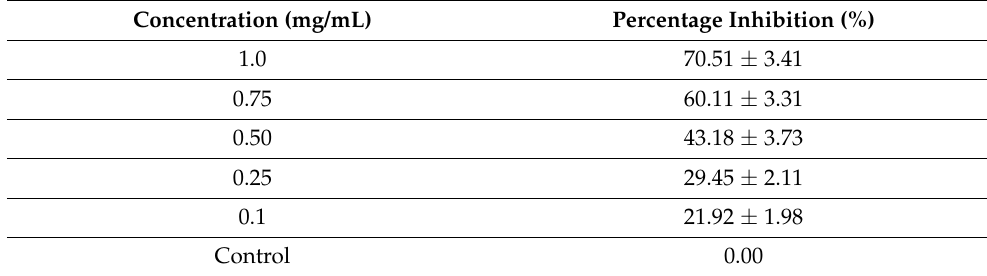
Figure 7. Antifungal activity analysis of ZnO NPs, in vitro. A. niger was grown at different concentrations of ZnO NPs including 1 mg/mL ( A ), 0.75 mg/mL ( B ), 0.5 mg/mL ( C ), 0.25 mg/mL ( D ) and 0.1 mg/mL ( E ). ZnO NPs were not supplemented in control ( F ). Table 3. Growth inhibition of A. niger at different concentrations of ZnO nanoparticles.